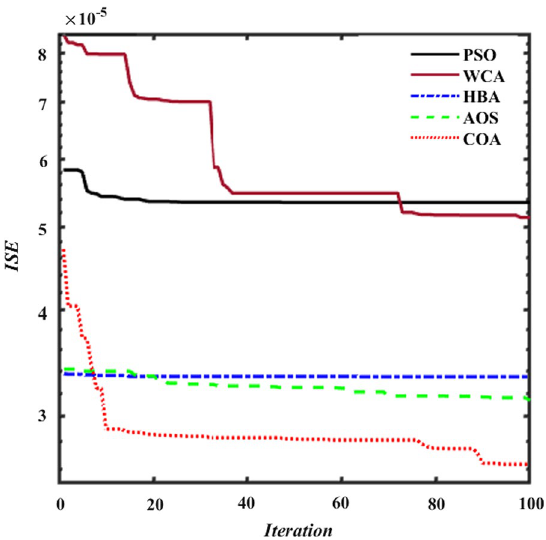
Fig. 7 Comparison of ISE convergence for the five used optimizers of the two‑area power system including PID controllers